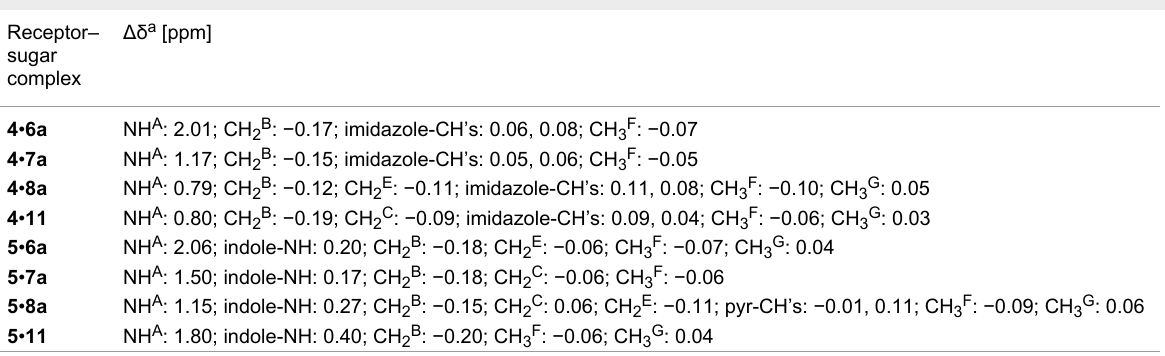
Table 2: Change in chemical shift a observed during 1 H NMR titrations of receptor 4 or 5 with sugar 6a , 7a , 8a or 11 in CDCl 3